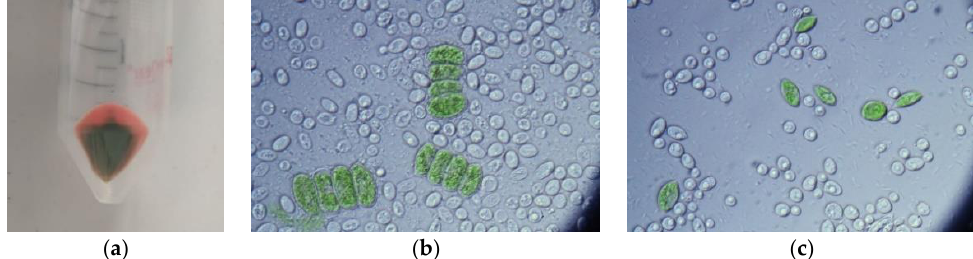
Figure 6. Collected biomass of co-cultivation ( a ) and microscopic images of co-culture of Rhodotorula kratochvilovae and Desmodesmus quadricauda; ( b ) Rhodotorula kratochvilovae and Desmodesmus acutus ( c ) after 96 h. Microscopic images are 100× magnified.